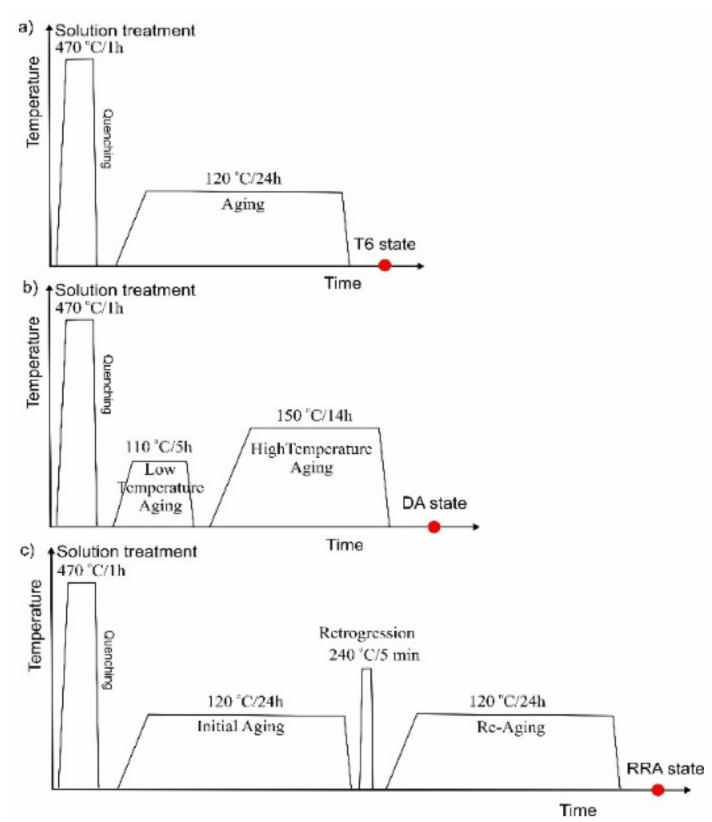
Figure 1. Diagram of the heat treatments: ( a ) T6, ( b ) DA, and ( c )